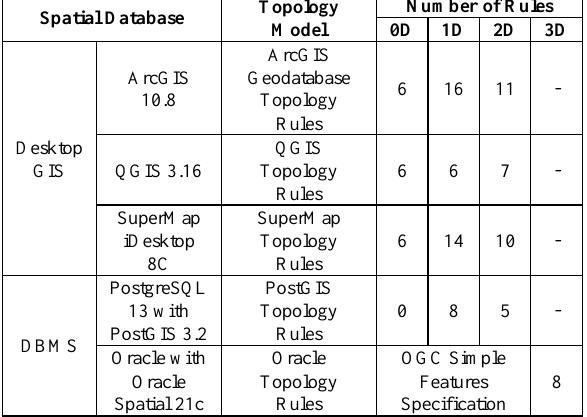
Table 1. Summary of topology for spatial databases.